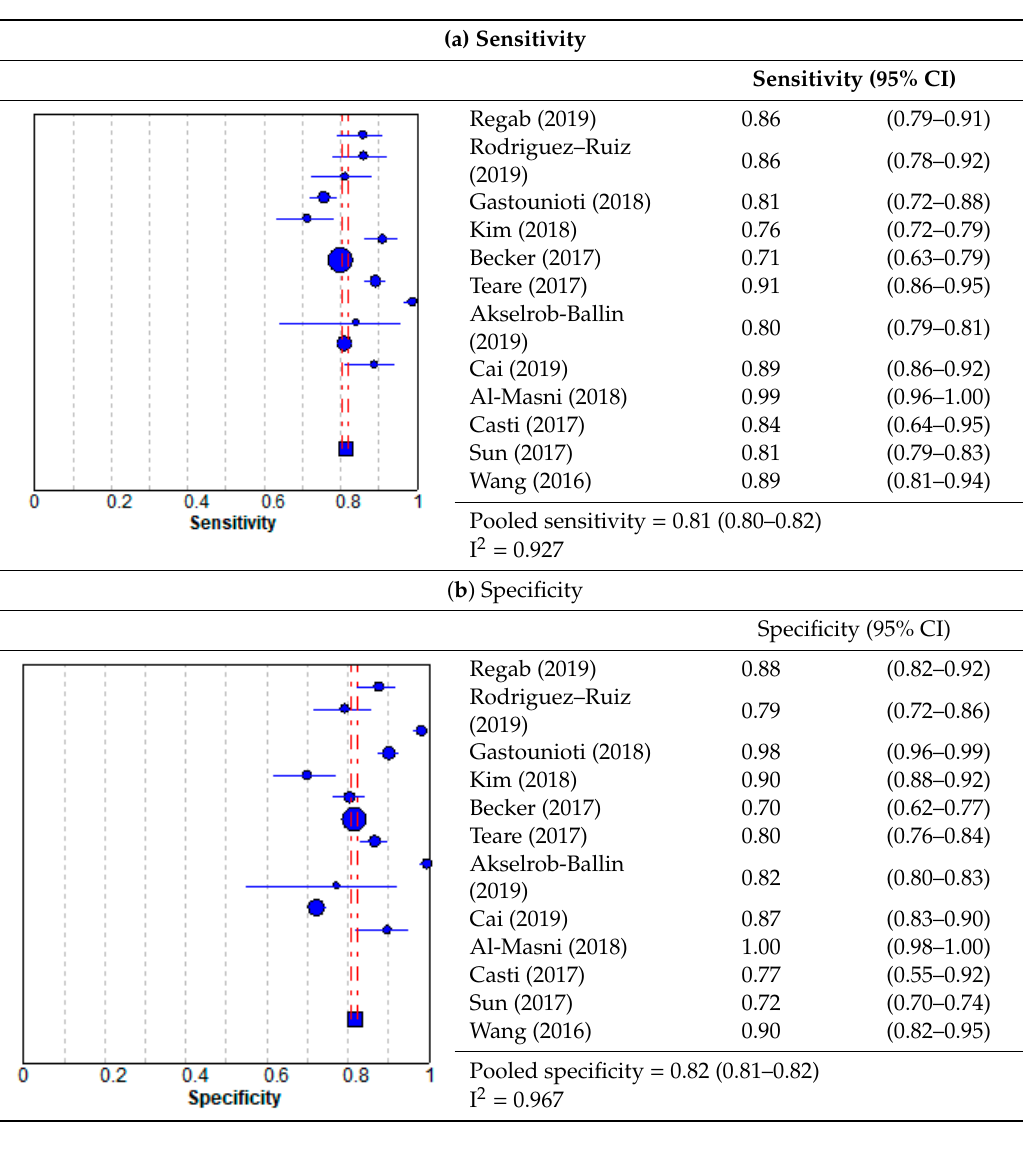
Table 3. Forest plot of the previous studies showing the pooled ( a ) sensitivity and ( b ) specificity on performance of deep learning algorithm for breast cancer detection in mammograms. CI, confidence interval.